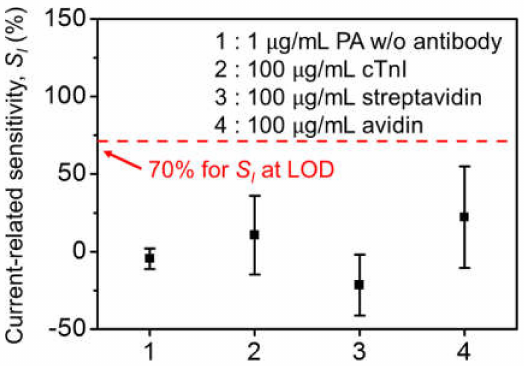
Figure 7. Selectivity test with 1 µ g/mL PA without surface functionalization, 100 µ g/mL cTnI, streptavidin, and avidin with surface functionalization at I D,Ab = 100 pA.